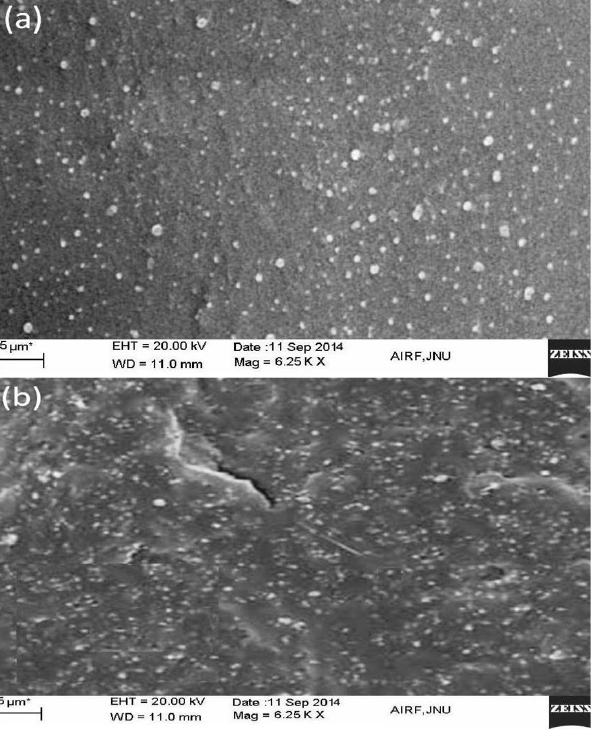
Fig. 2. SEM images of PA66/CaCO3: a) Micro-composites, b) Na- no-composites: magnification of 6.25 kx.